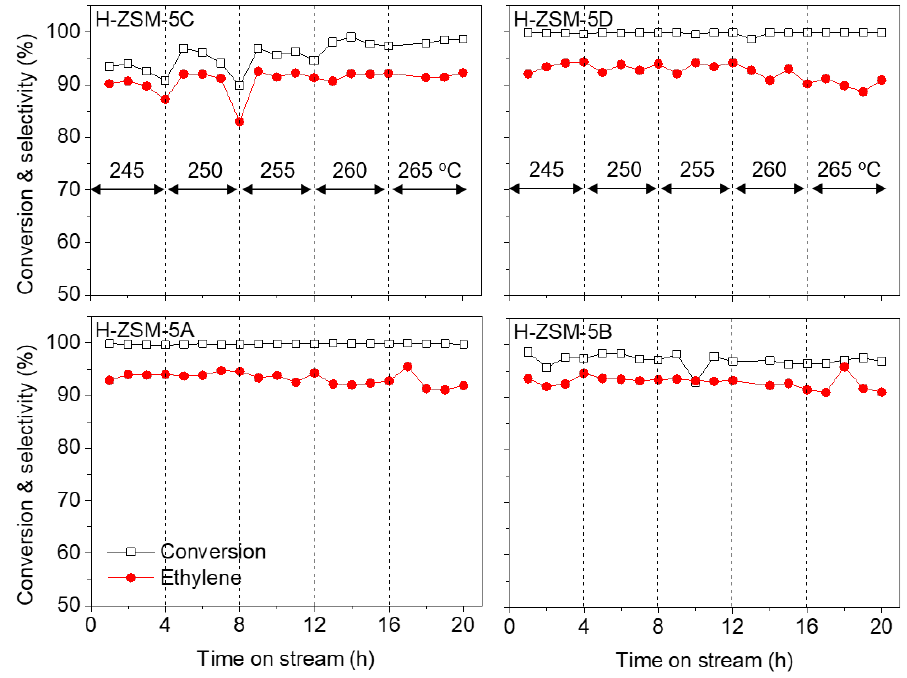
Figure 5. Ethanol conversion (□) and selectivity to ethylene (● ) as a function of time on stream (TOS) in dehydration of bioethanol over 0.5 g of H-ZSM-5A, H-ZSM-5B, H-ZSM-5C, and H-ZSM-5D at – 265 °C and 2 h − 1 WHSV.